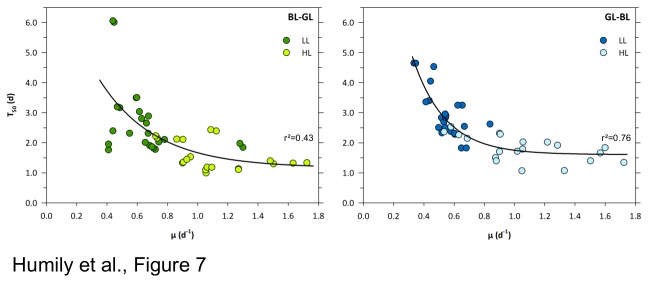
Correlations between growth rate (µ, days) and half maximal acclimation time (T50, days) for twelve Synechococcus strains.Shifts to another light quality (BL to GL and vice versa) were performed under two light intensities. LL and HL correspond respectively to 20 and 75 µmol photons m-2 s-1 of BL or GL. Data correspond to two biological replicates for each strain and each light condition.